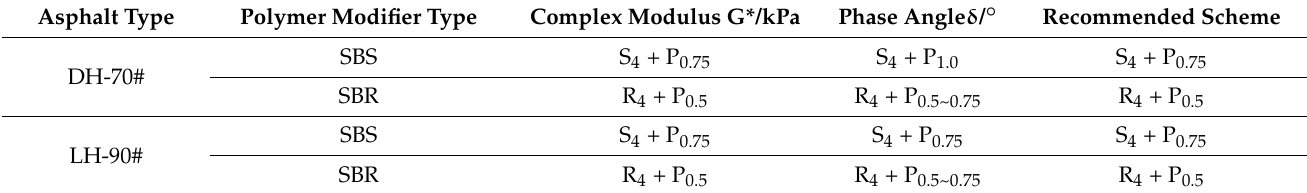
Table 4. Schemes of compound modified asphalt with similar performance to S6/R6.